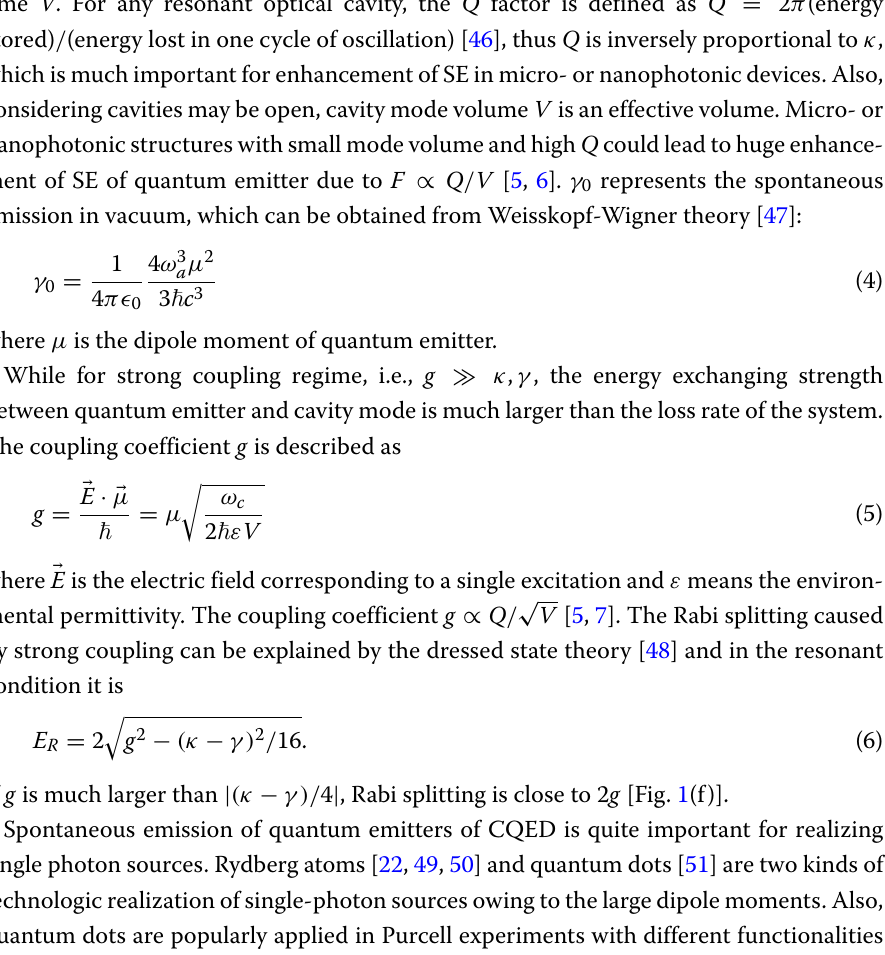
which is proportional to quality factors Q and inverse proportional to cavity mode vol- ume V . For any resonant optical cavity, the Q factor is defined as Q = 2 π